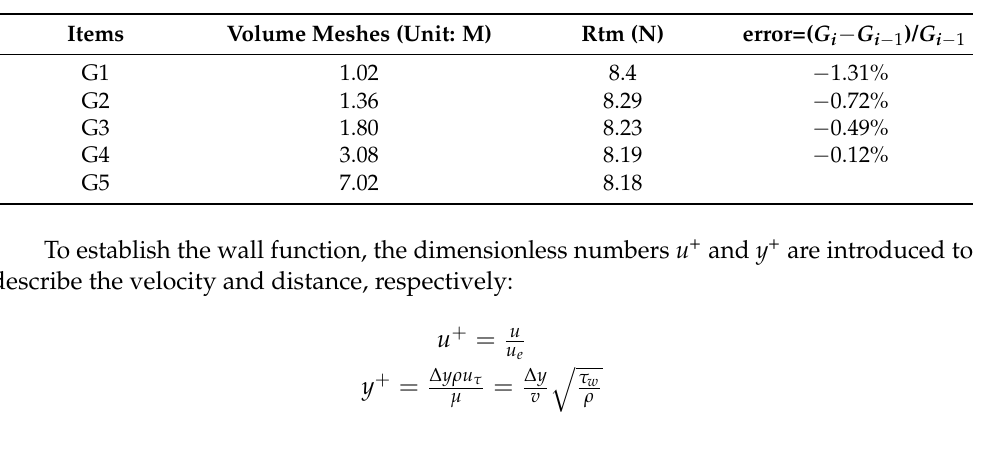
Table 3. Grid comparisons at 0 ◦